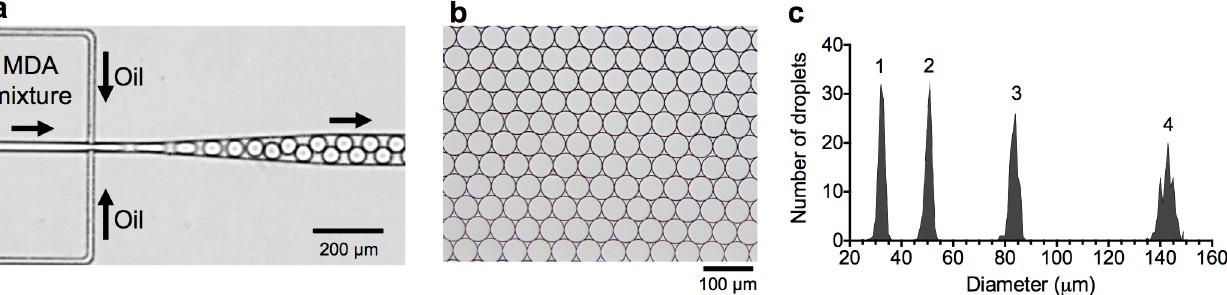
Fig 1. Generation of monodisperse picoliter droplets for compartmentalized MDA reactions. (a) Microphotograph of droplet generation at the microfluidic cross-junction. The MDA mixtures containing single-cell genomes were introduced into the microfluidic device for encapsulation in droplets at the single molecule level. (b) Microphotograph of droplets collected from the microfluidic droplet generator. (c) Size distribution of droplets used for compartmentalized MDA reactions. Ratio of flow rates (water: oil): (1) 2:4, (2) 3:3, (3) 3:1, and (4) 6:1 μ L/min. Junction width: (1): 8.5 μ m, (2 and 3): 17 μ m, and (4): 34 μ